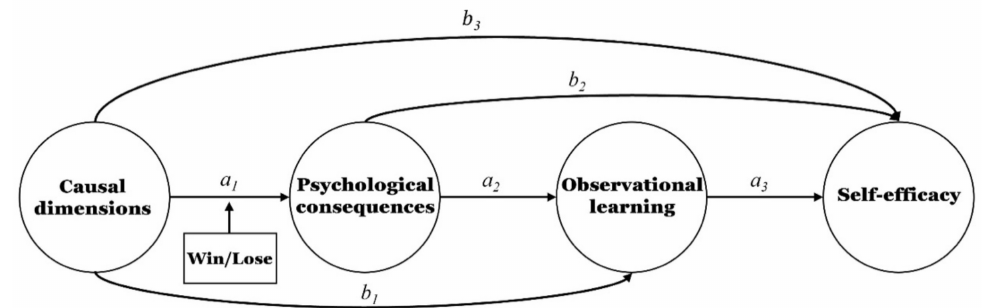
Figure 2. Two serial multiple mediator